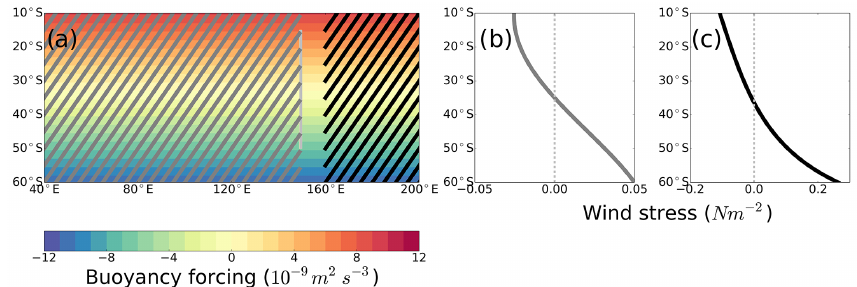
Figure 3. Configuration of the conceptual two-layer model. (a) Model domain, applied buoyancy forcing (shading) and two areas where wind stress is applied (hatches). The light grey area at 150 ◦ E indicates the elongated island. (b) Wind stress simulating a gyre (grey) and (c) ITF (black) applied to respective areas as indicated in panel (a) .